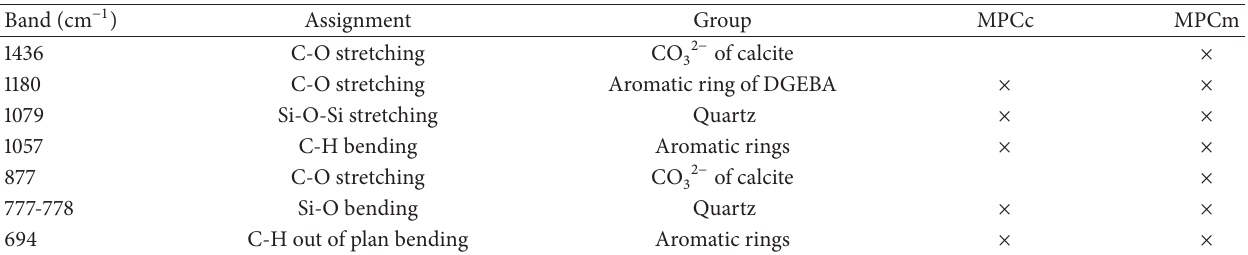
Table 8: Characteristic bands of MPC observed with FTIR spectra.